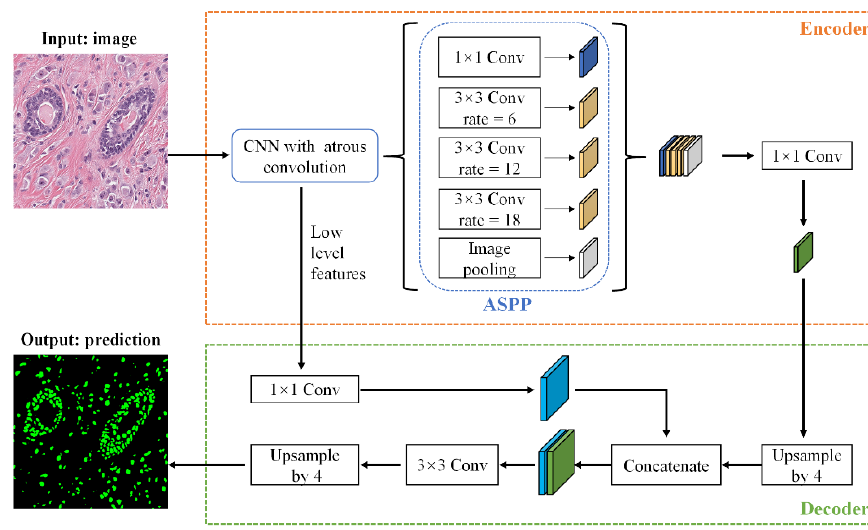
Figure 1. The architecture of DeepLabV3+ applied to nuclei segmentation.